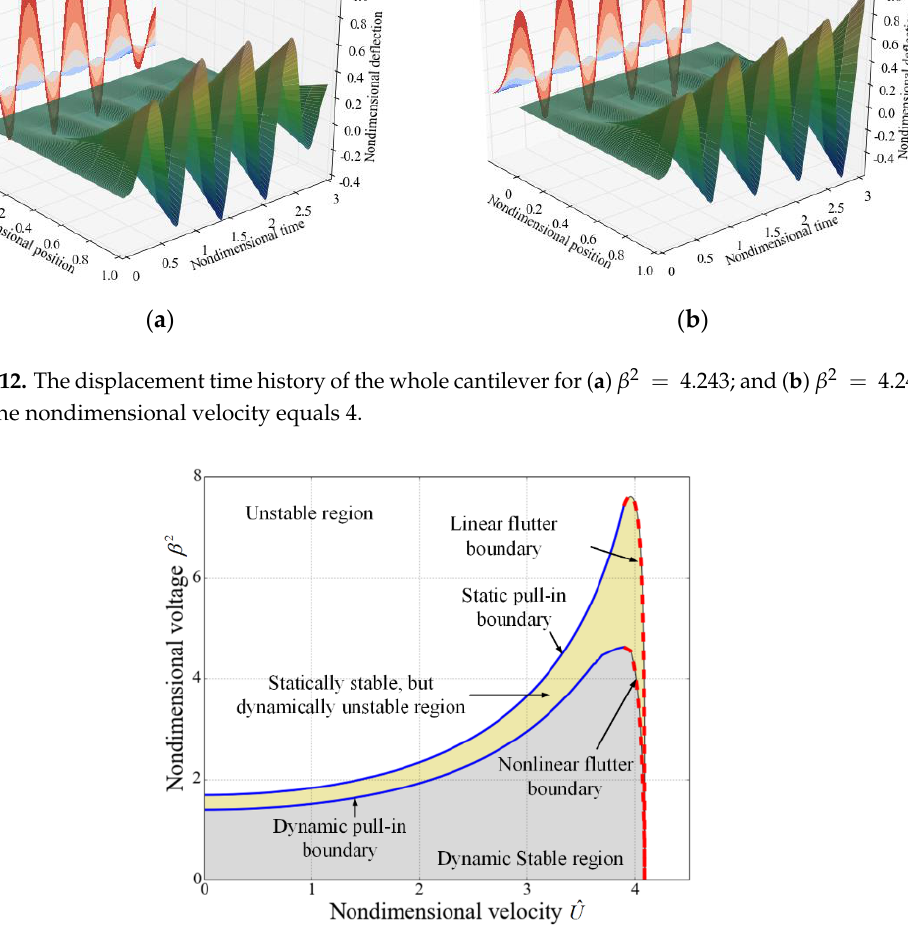
Figure 13. Dynamic and static stability regions in the ( ˆ U , β 2 ) plane for suspended microchannel resonators.